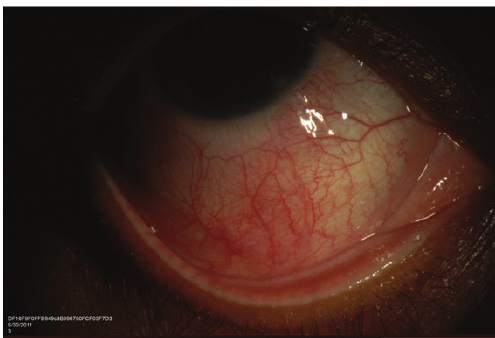
Figure 1: Slit-lamp photo demonstrating di ff use anterior scleritis in a patient with